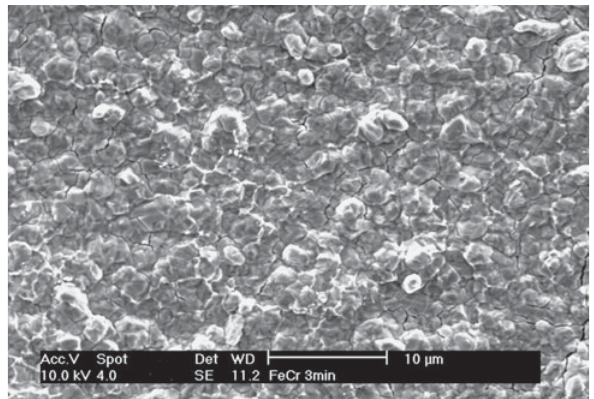
Figure 6. Surface of the FeCr alloy sulfidized for 3 min at 700